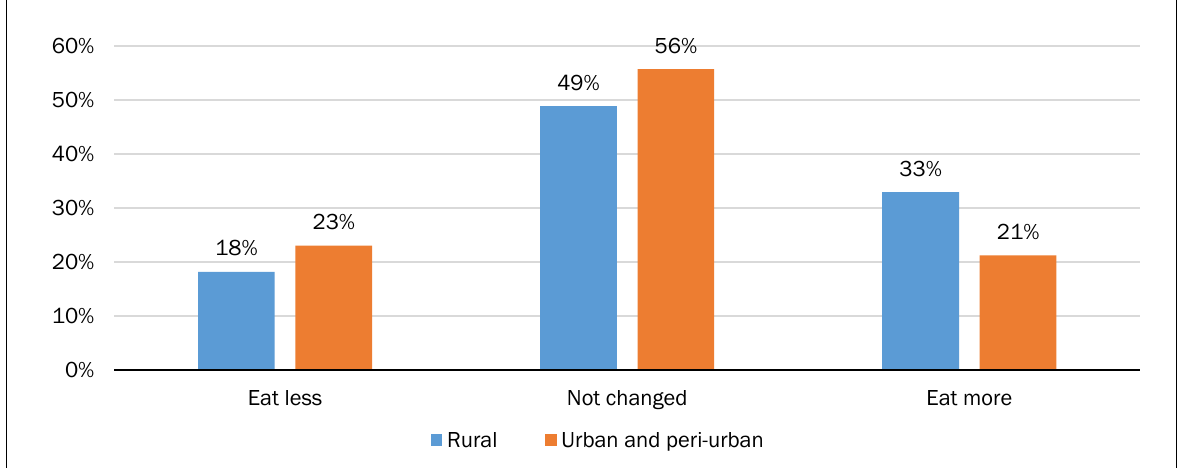
Table 2 . Proportions of Consumers’ Frequency of Bean Consumption a Week Before COVID -19 (in